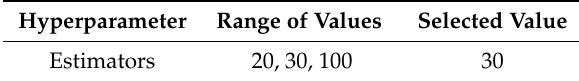
Table 6. Bagged tree hyperparameters selected through